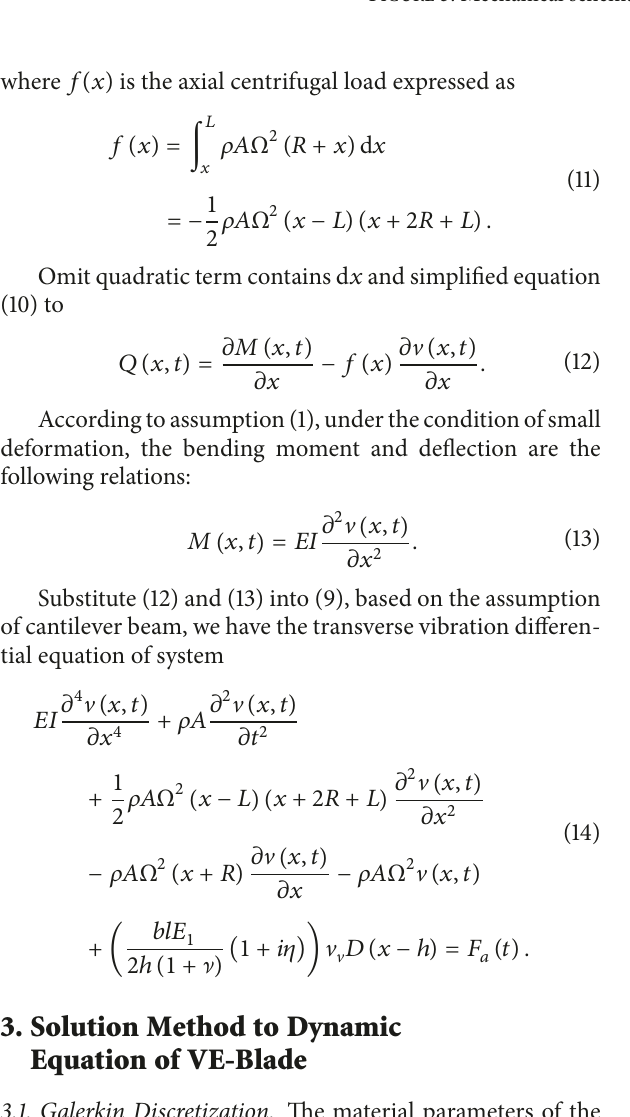
Figure 3: Mechanical schematics of blade